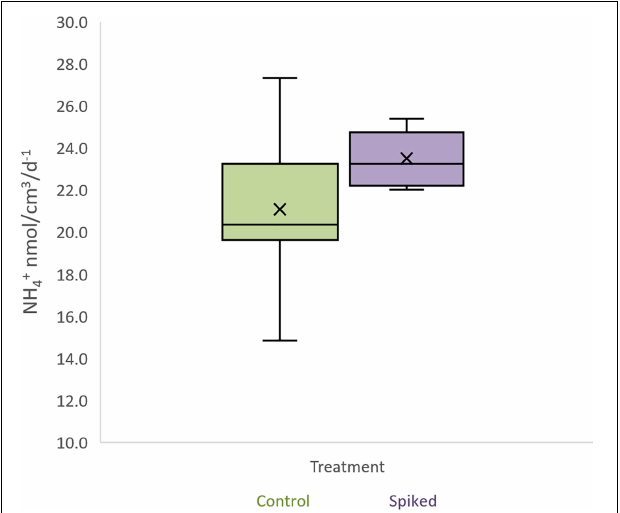
FIGURE 8 | Potential nitrification rates for control and spiked samples. In the box plots, the boundary of the box closest to zero indicates the 25th percentile, a black line within the box marks the mean, and the boundary of the box farthest from zero indicates the 75th percentile. Whiskers above and below the box indicate the 10th and 90th